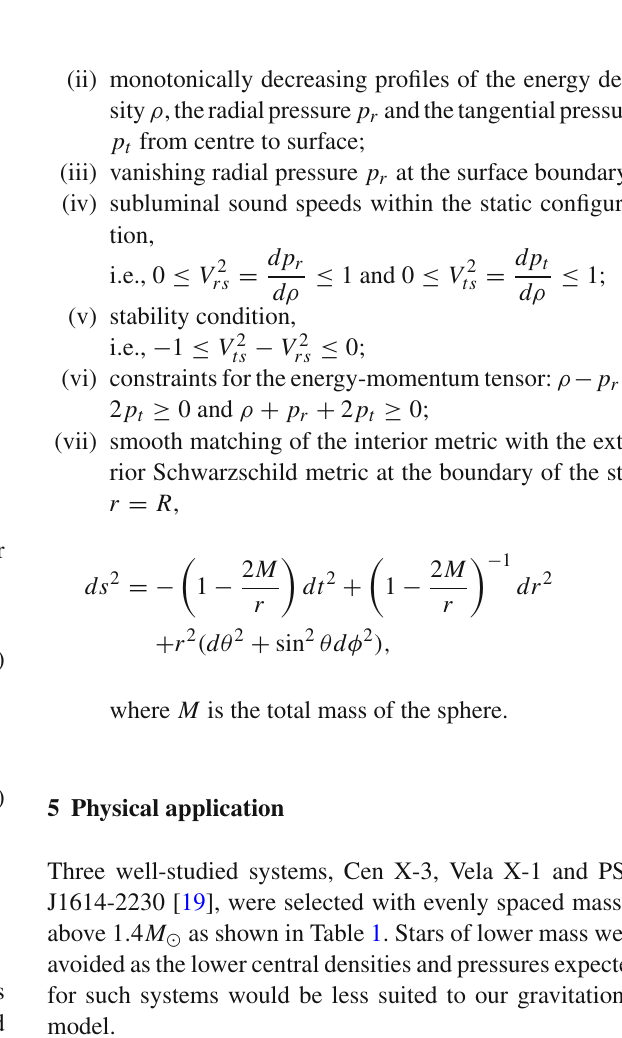
Fig. 2 Pressure profiles ( K = − 5)